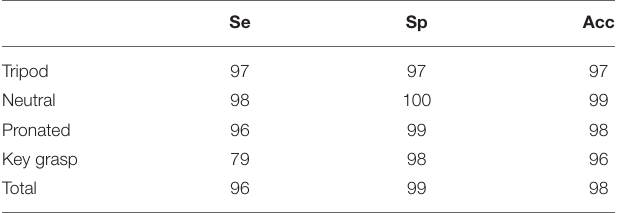
TABLE 4 | Performance metrics of experiment 2 [Se, sensitivity (%); Sp, specificity (%); Acc, accuracy (%)].